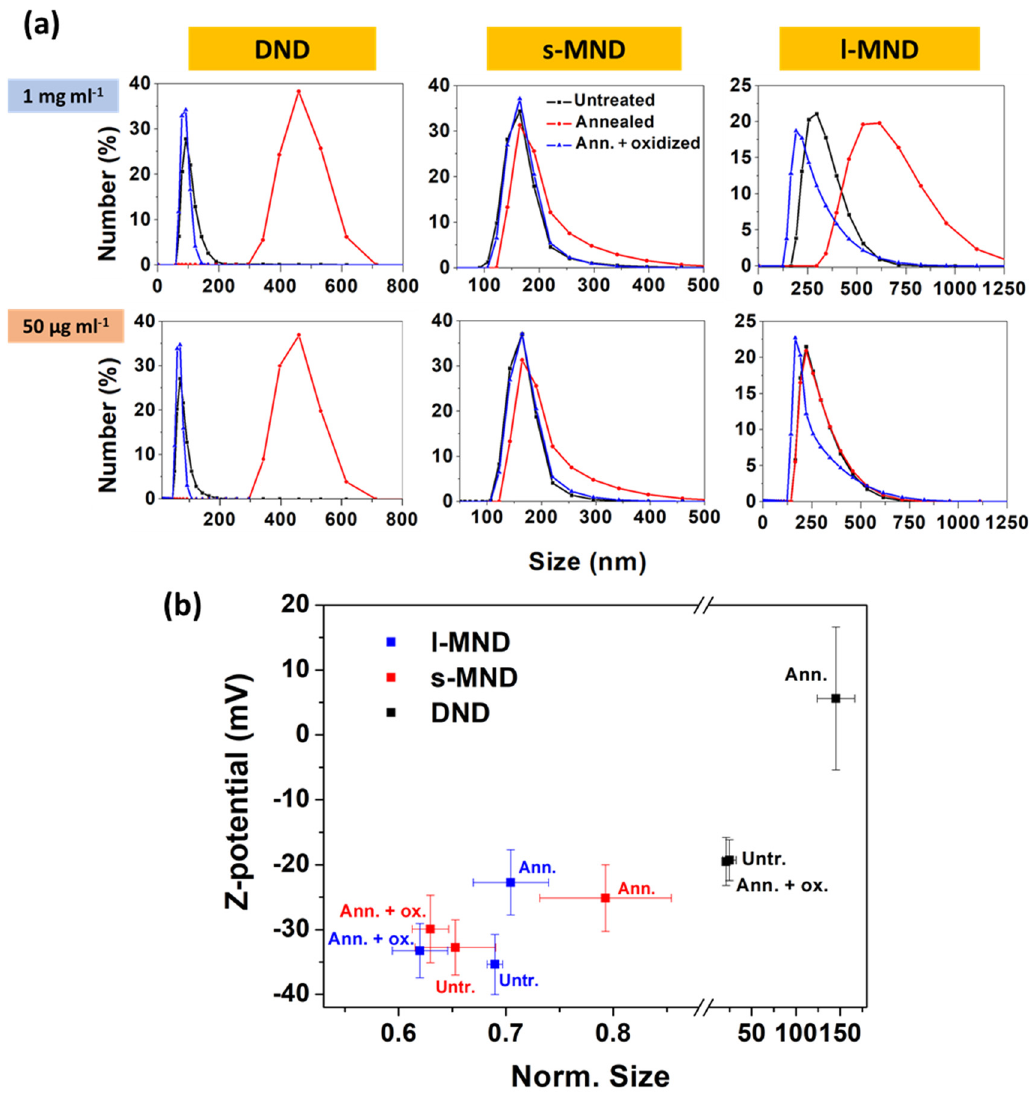
Figure 6. ( a ) DLS size distribution by number and ( b ) Z-potential as functions of the average size of the distributions by number, normalized by the median dimension of the primary nanoparticles.